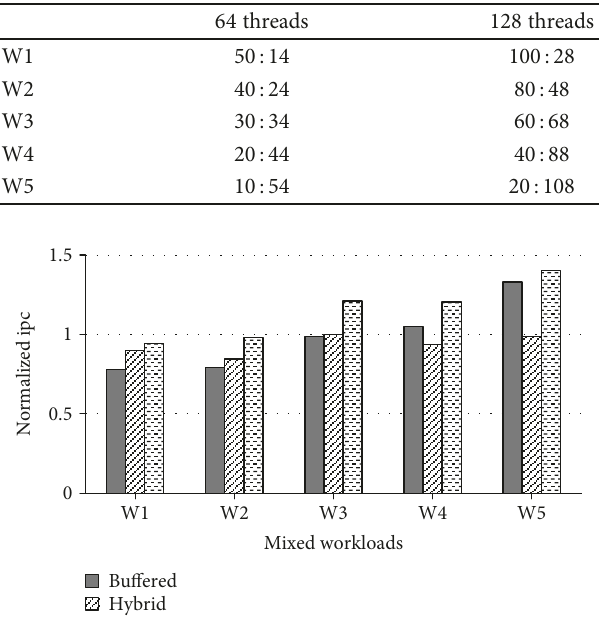
Figure 10: Normalized IPC of hybrid load with 64